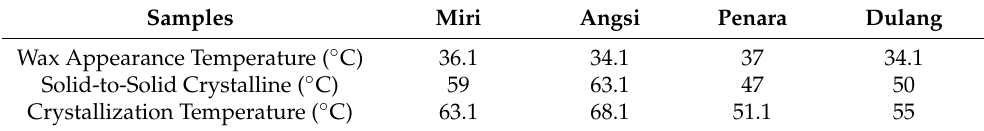
Table 1. WAT, solid-to-solid crystalline, and crystallization temperatures for different crude oils.